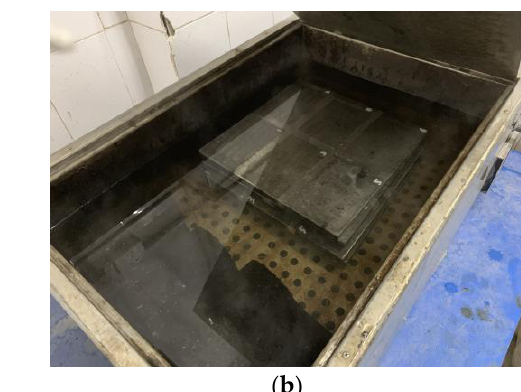
Figure 4. Epoxy maintenance: ( a ) Room temperature saturated salt solution water bath; ( b ) 60 °C water bath.